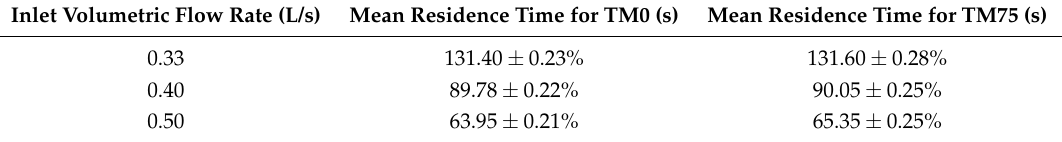
Figure 9. Normalized residence time distribution of TM0 pellets in the fish tank. It is based on total number of particles around 42,000, injected at the surface. Inlet volumetric flow rate 0.5 L/s. Table 4. Summary of mean residence times for all inlet flow rates used in our CFD simulations. The confidence intervals are derived from standard deviations of residence times of the injected particle samples which were around 40 thousand in all three